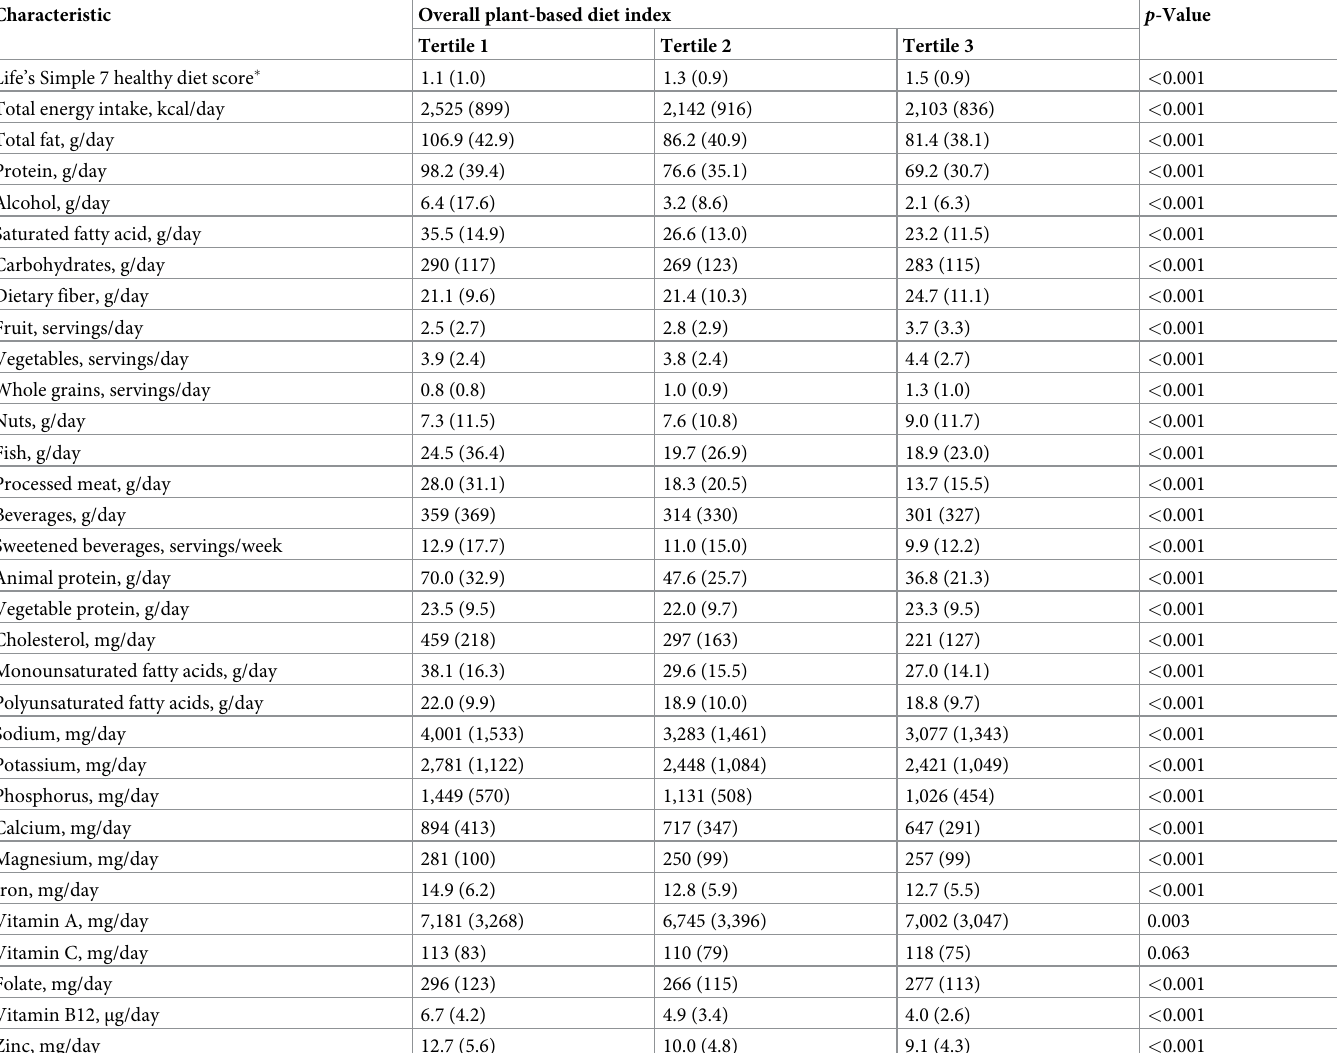
Table 2. Selected nutritional characteristics by tertiles of plant-based diet index in the Jackson Heart Study.